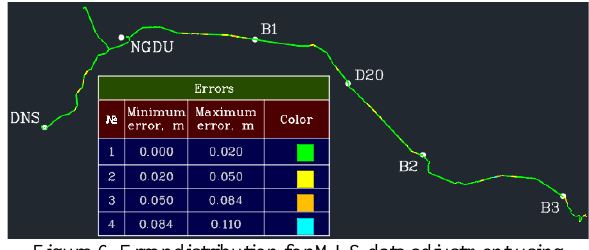
Figure 6. Error distribution for MLS data adjustment using check points every 2 km and control points every 2 km